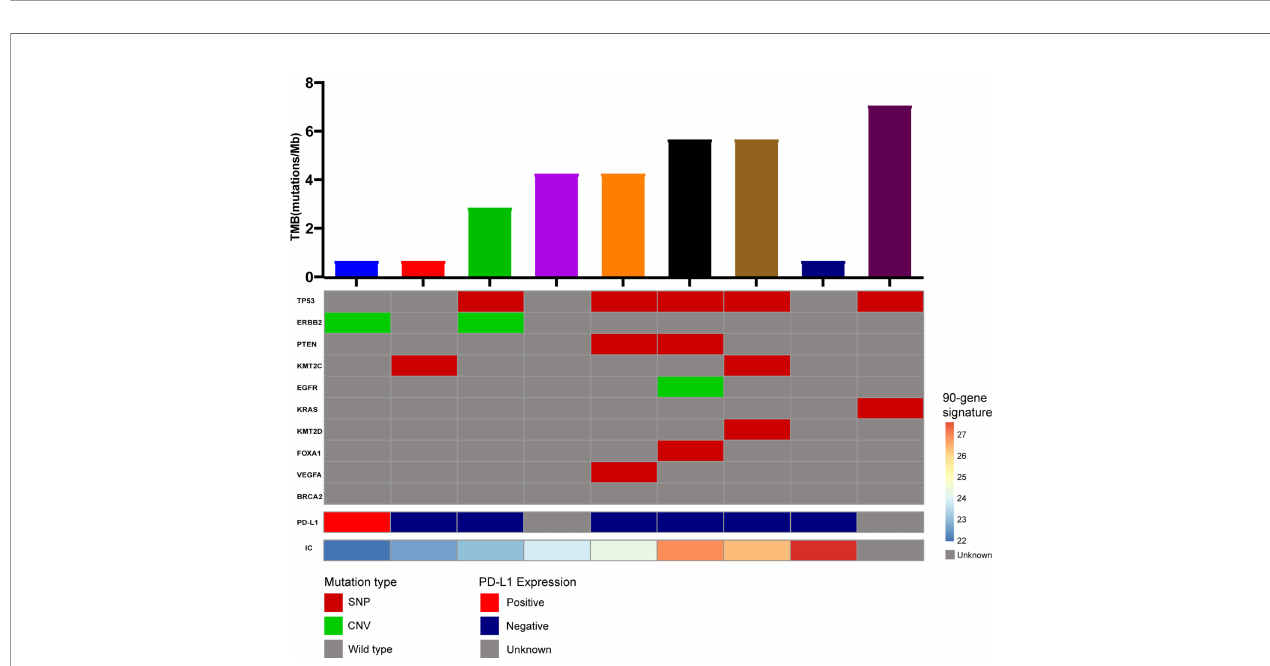
FIGURE 5 | NGS panel sequencing of metastatic tissues from 9 CUP